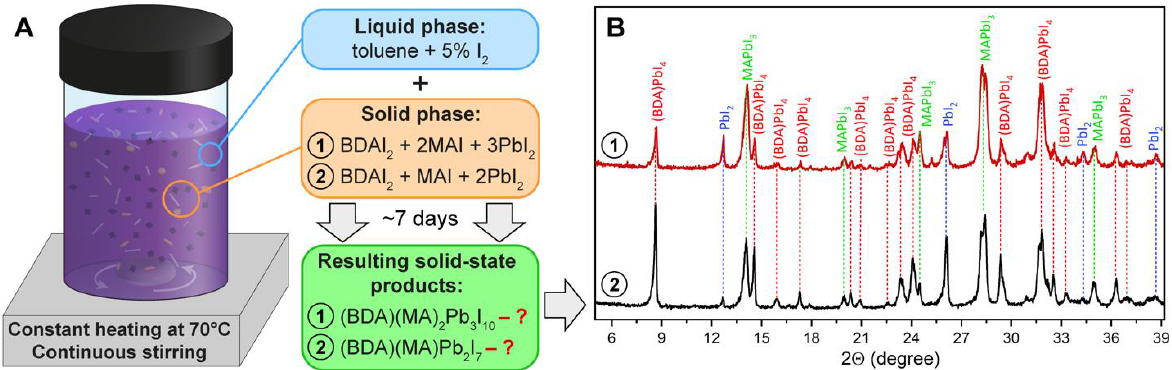
Figure 2. ( A ) The scheme of the experimental setup for the study of reactivity of the mixture of BDAI 2 + MAI + PbI 2 powders with component ratios corresponding to (BDA)(MA) 2 Pb 3 I 10 (1) and (BDA)(MA)Pb 2 I 7 (2). The role of component transfer media in 5% I 2 solution in dry toluene. ( B ) XRD patterns of the resulting solid-state products after 7 days of continuous heating and stirring of the initial precursor mixtures. Each peak is labeled by the corresponding phase: (BDA)PbI 4 (red), PbI 2 (blue); MAPbI 3 (green).